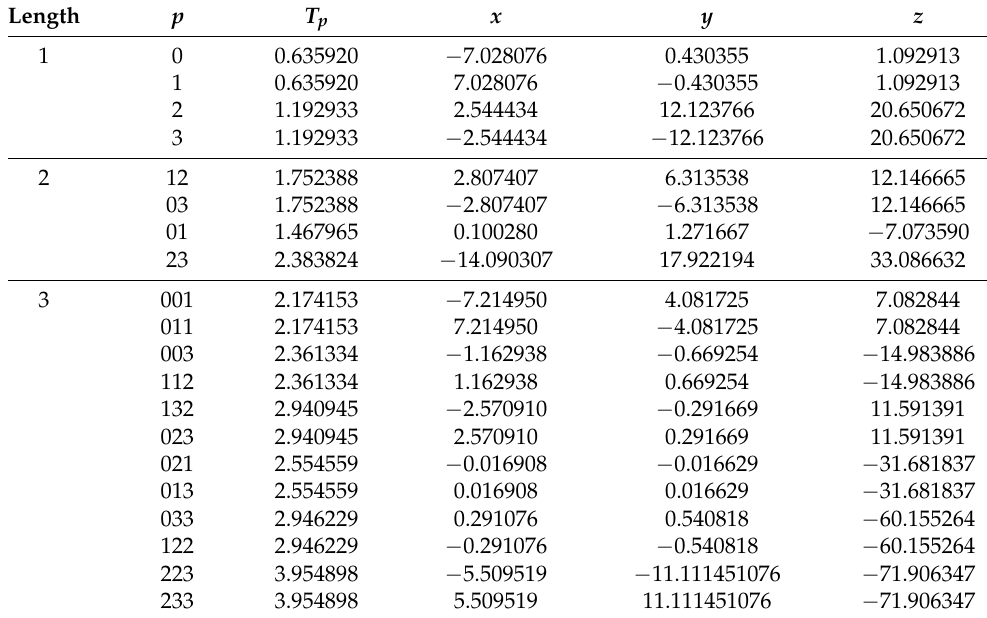
Figure 15. Four basic building blocks in system (1) for parameters ( a , b , c , k ) = ( 10,100,11.2, − 0.2 ) : ( a ) cycle 0; ( b ) cycle 1; ( c ) cycle 2; and ( d ) cycle 3. Table 1. Twenty unstable periodic orbits embedded in hidden chaotic attractor of system (1) for ( a , b , c , k ) = ( 10,100, 11.2, − 0.2 ) , showing topological length, itinerary p , period T p , and three coordi- nates of a point on the periodic